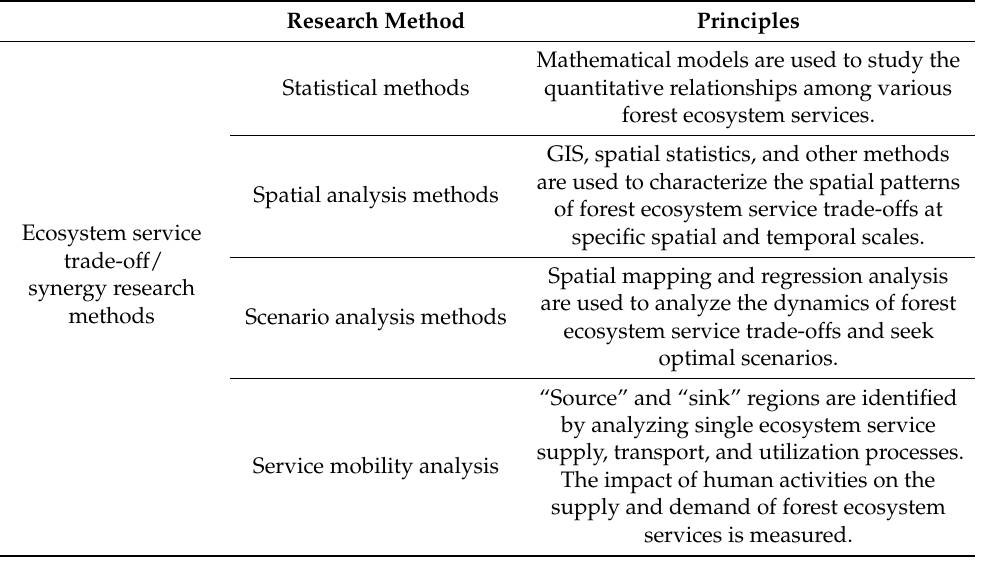
Table 2. Research methods of ecosystem service